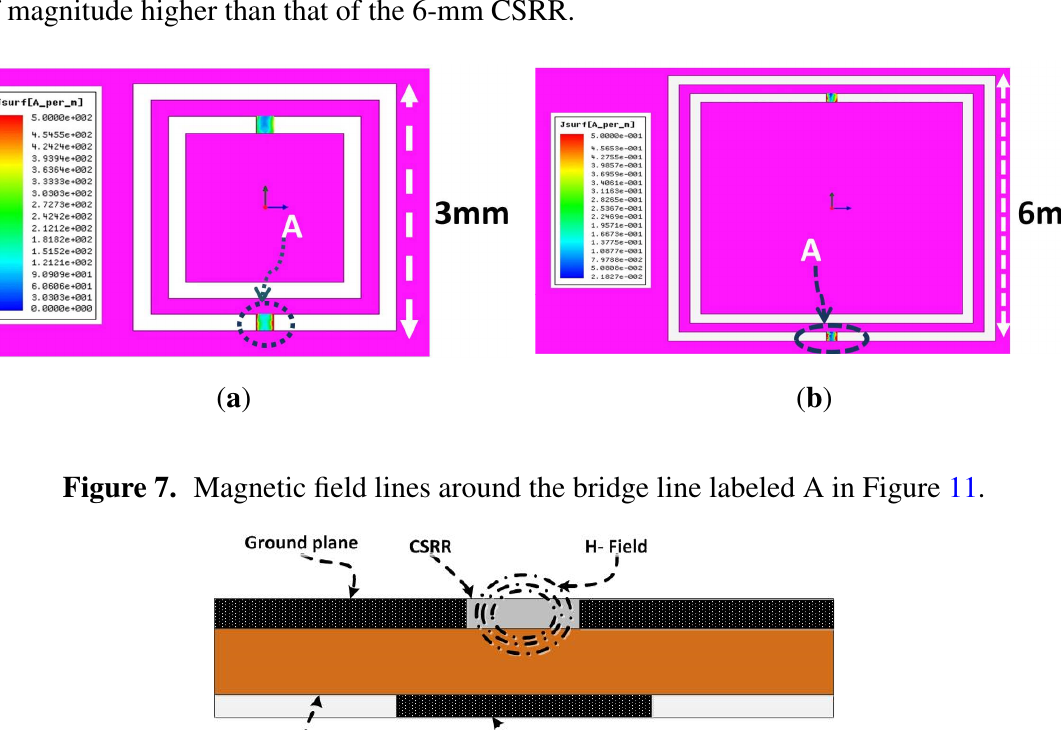
Figure 6. Current distribution density on CSRRs at the resonance frequency. The bridge labeled A shows the area of high current density. ( b ) A CSRR of a length of 6 mm. The surface current on the 3-mm CSRR is one order of magnitude higher than that of the 6-mm CSRR.